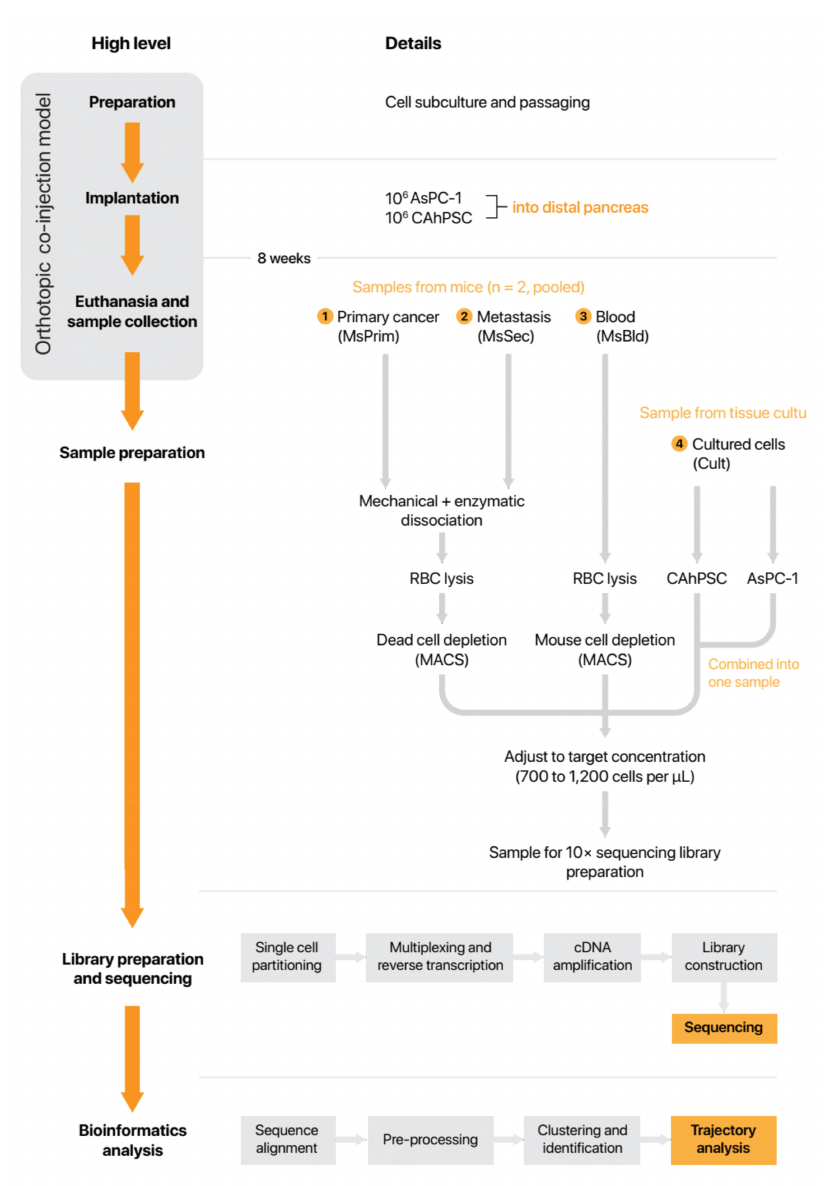
Figure A2. Flowchart summarising Model 2 (single cell RNA characterisation). Four samples were analysed. Three of these samples were derived from n = 2 mice: primary cancer (MsPrim), metastatic (secondary) cancer deposits (MsSec) and portal vein blood (MsBlood). The fourth sample was of cultured cancer associated human PSCs (CAhPSC) and AsPC-1 pancreatic cancer cells. This latter sample was used as a reference during analysis of mouse-derived cells. Tumours were dissociated into a single cell suspension and under-went dead cell depletion with magnetic cell separation (MACS), while circulating tumour cells and circulating pancreatic stellate cells were enriched using mouse-cell depletion. Abbreviations: CAhPSC, cancer-associated human pancreatic stellate cells. MACS, magnetic cell separation. RBC, red blood